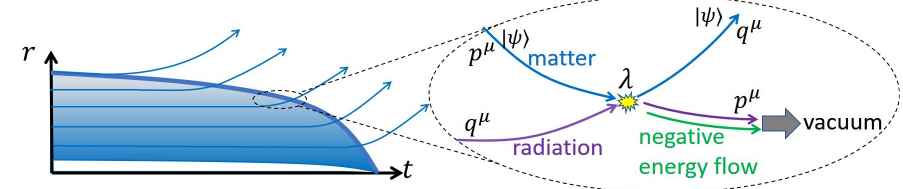
Figure 16. Time evolution of the evaporating black hole with interaction. The matter with the information | ψ (cid:105) and energy-momentum p µ comes and is scattered with a certain probability by the radiation with energy-momentum q µ . Then, the ingoing radiation should approach to a vacuum state through interaction with the negative energy